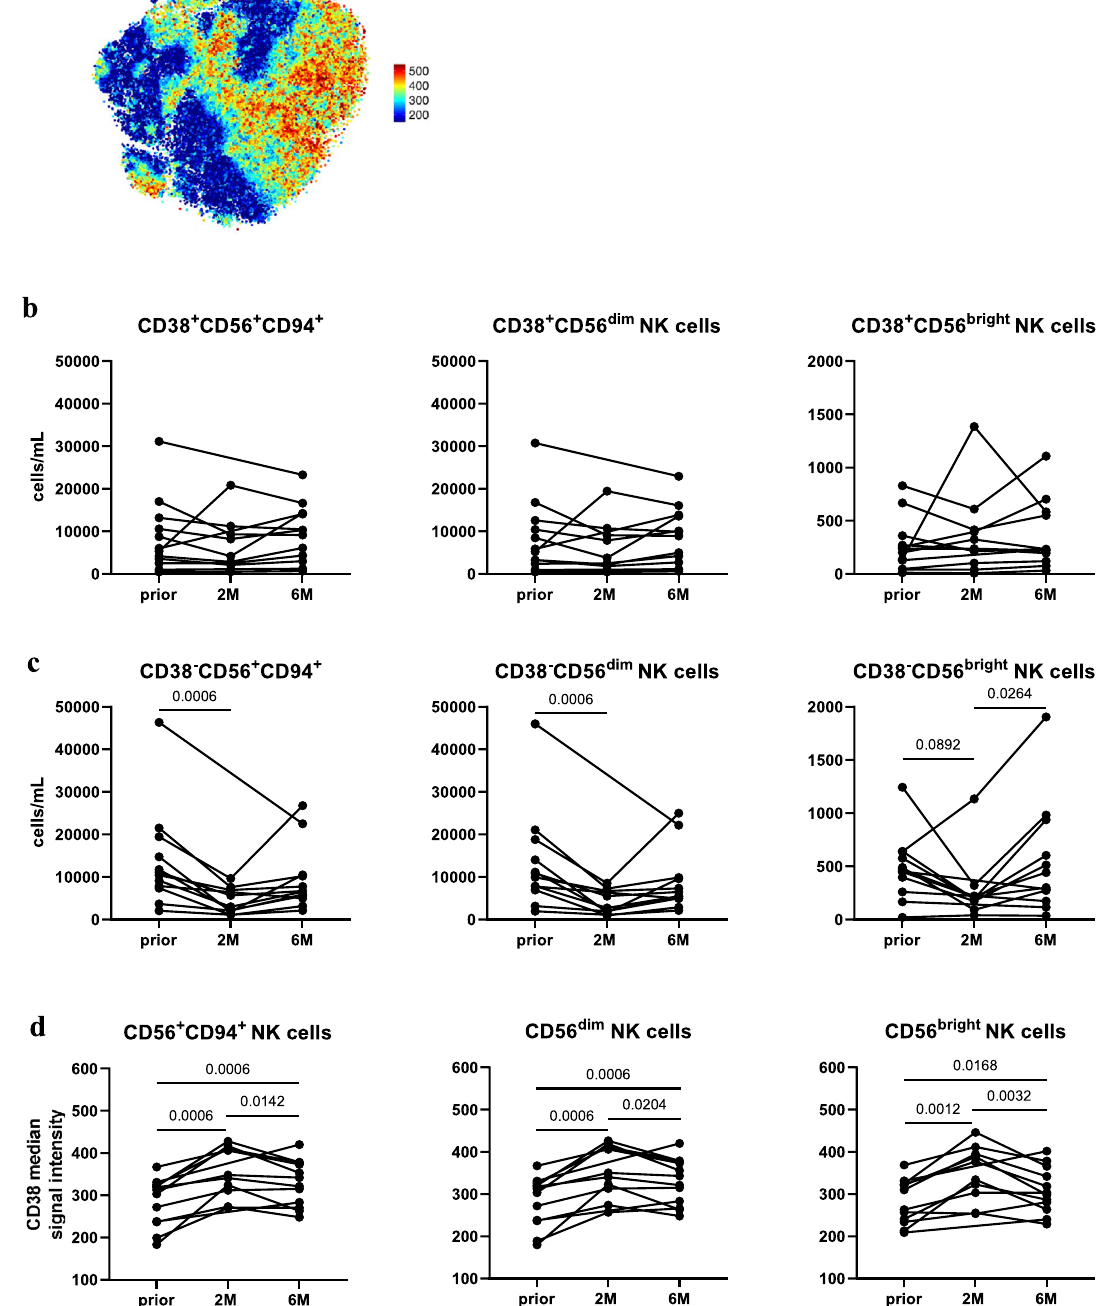
Figure 3. CD38+ but not CD38− NK cells remain unaffected by CladT. ( a ) Expression levels of CD38 among CD56+CD94+ NK cells on Fast Interpolation-based t-stochastic neighbor embedding (FIt-SNE) plots. A subsample of up to 70,000 cells from all study participants (non-MS controls, MS patients from all timepoints and batch controls) were included for the generation of FIt-SNE plots. ( b ) CD38+CD56+CD94+, CD38+CD56dim, CD38+CD56bright NK cells as cells/mL in MS patients at baseline ( prior , n = 12), and 2 ( 2M , n = 10), and 6 months ( 6M , n = 12) following administration of CladT. ( c ) CD38-CD56+CD94+, CD38− CD56dim and CD38−CD56bright NK cells as cells/mL in MS patients prior (n = 12), 2M (n = 10), and 6M (n = 12) following administration of CladT. ( D ) CD38 median signal intensity of MS patients at prior (n = 12), 2M (n = 10), and 6M (n = 12) following administration of CladT. A linear mixed-effects model was calculated to compare between MS patients before and after treatment. 4999 permutations were then run to calculate p-values. Holm’s corrections were used for multiple comparisons which were performed to compare the different timepoints ( prior , 2M & 6M ). p-values of p < 0.1 are indicated on the